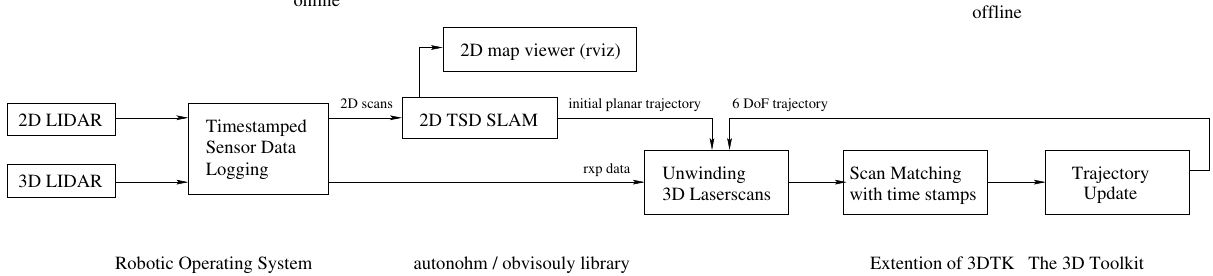
Figure 3. Overall system architecture. The ROS nodes can run o nline, i.e., during data acquisition, while the map optimization is executed